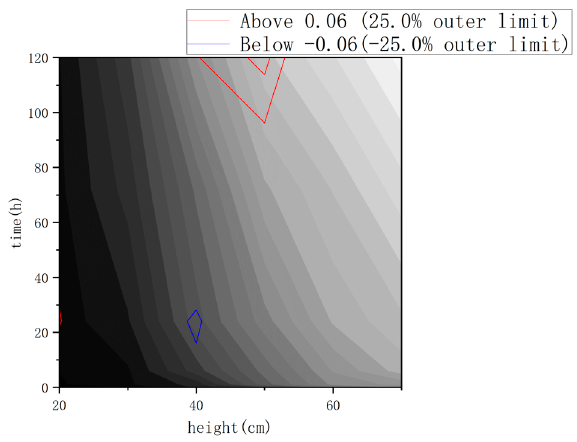
Figure 10. Fitted surface plot of apple bruise area.